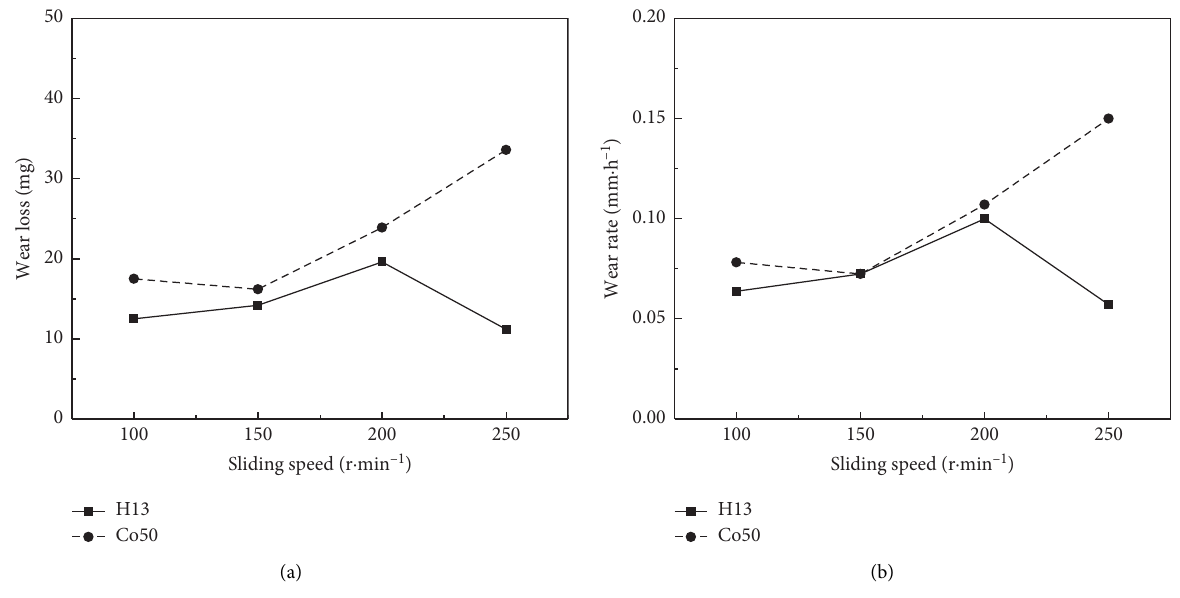
Figure 8: Effect of sliding velocity on (a) wear losses and (b) wear